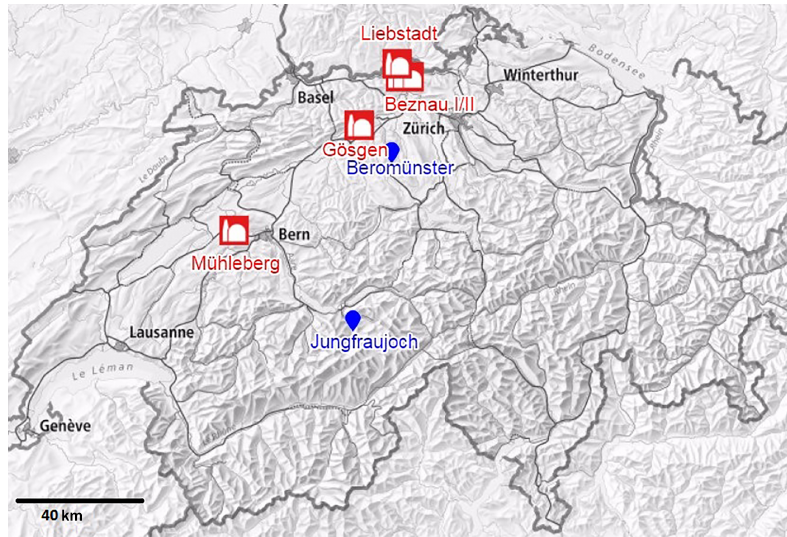
Figure 1. The geographical map of Beromünster and Jungfraujoch measurement sites (blue) as well as the five NPPs in Switzerland (red).